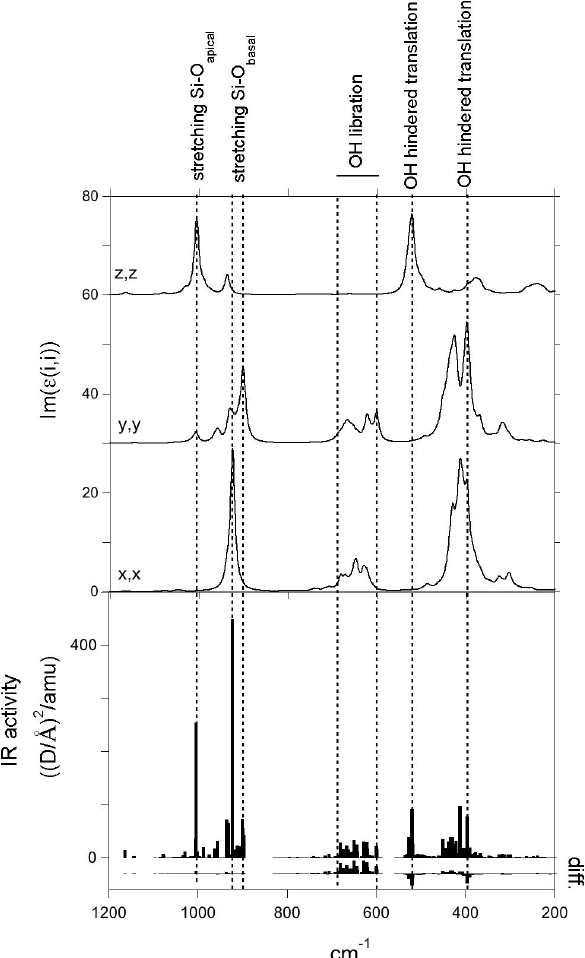
Figure 4. Imaginary part of the diagonal elements of the antigorite dielectric tensor reported as a function of frequency in the MIR range. The IR activities of the vibrational modes in (D/ Å ) 2 /amu are reported at the bottom as vertical sticks. Difference between IR activities computed with and without the contribution of hydrogen (see text) is also reported. Note that the position of the resonances of the dielectric tensor can differ from that of the bands in the ab- sorption spectrum computed for a specific particle